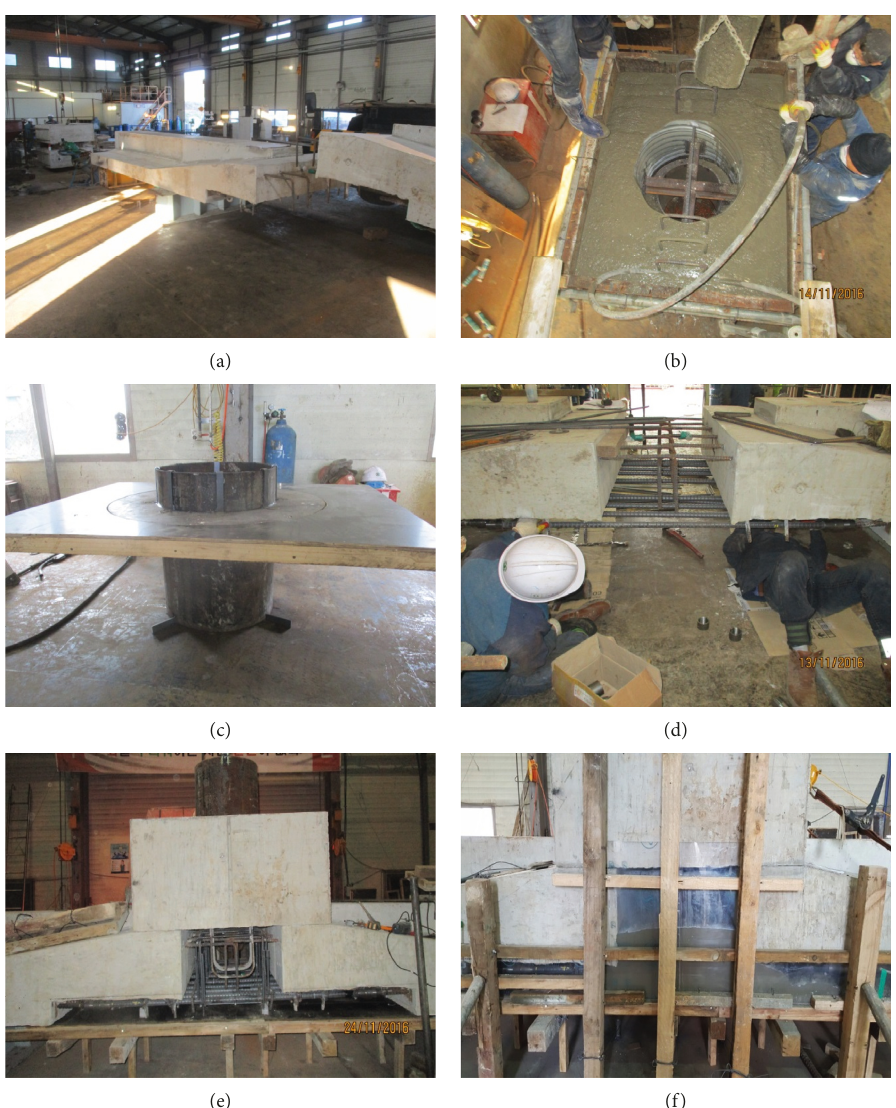
Figure 3: Fabrication procedures. (a) Fabrication of precast girders, (b) fabrication of precast bent cap, (c) fabrication of steel pier, (d) fastening the couplers, (e) placement of precast bent cap on girders, and (f) curing of